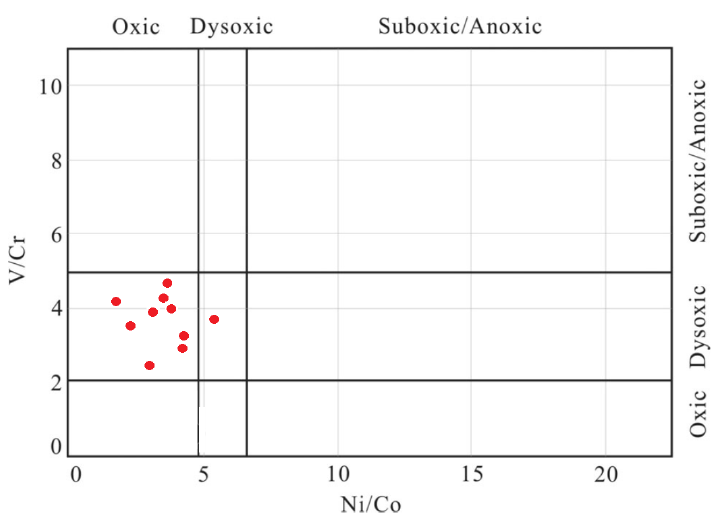
Figure 8. V/Cr vs. Ni/Co trace element ratios of stromatolites to find the redox conditions [54] . Table 5. Rare earth element (REE) contents of the stromatolites from Lake Salda, in parts per million (ppm; μg g – 1 ).